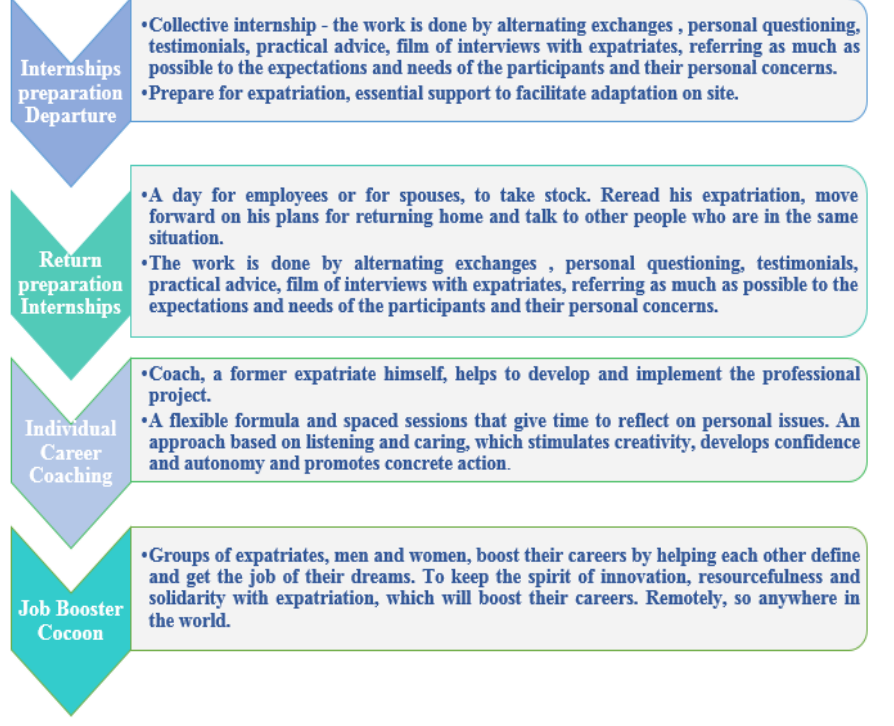
Fig. 2. Soft Skills